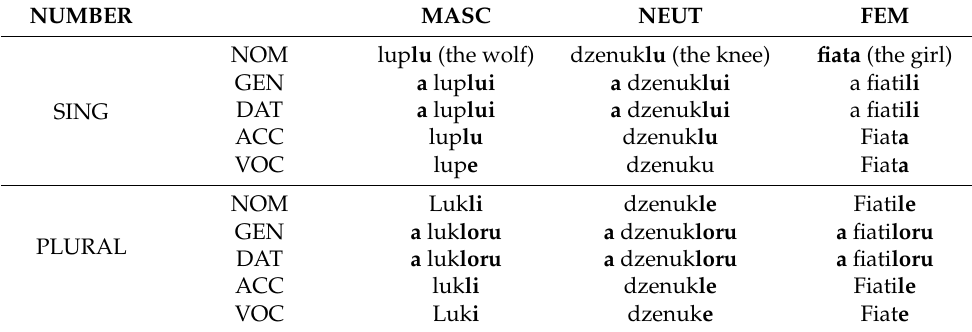
Table 3. Morphological marking of gender in VA.